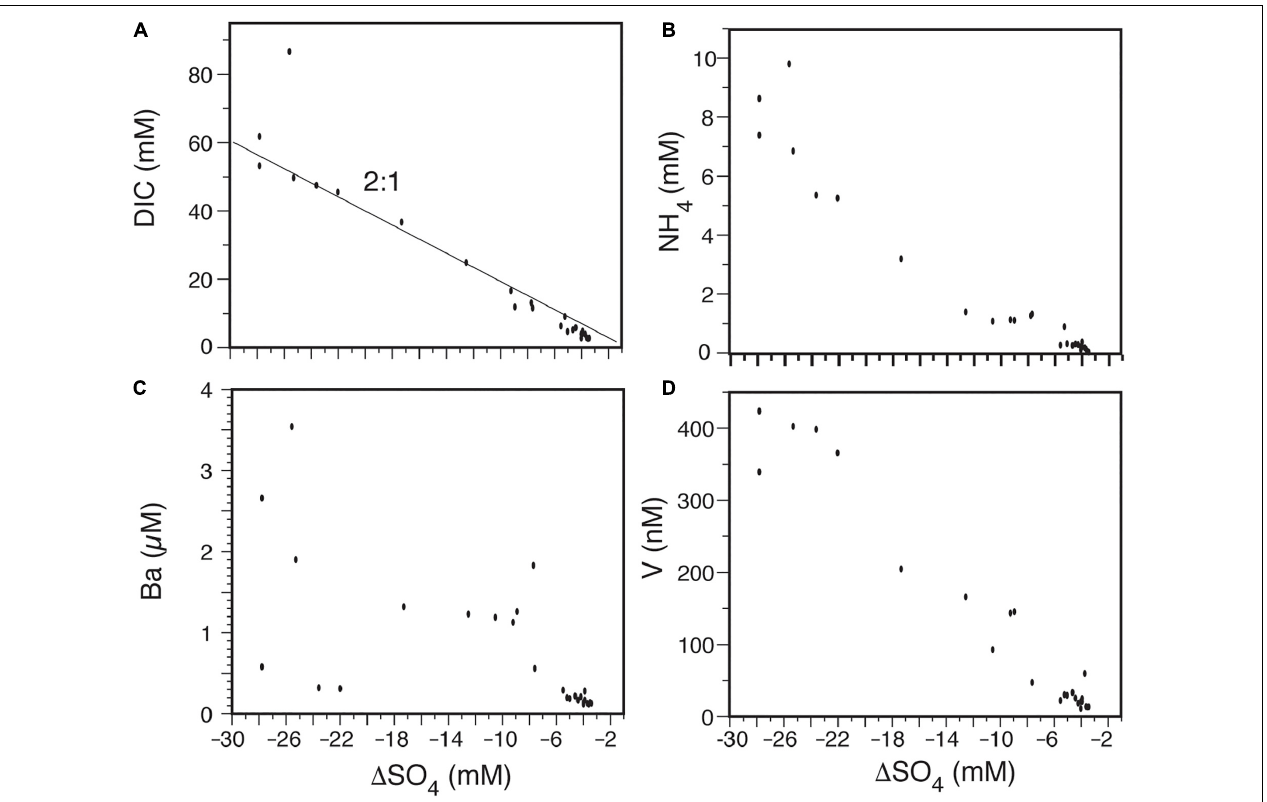
FIGURE 4 | Data from the Wadden Sea tidal flats, Germany, showing the relationship between sulfate depletion by C oxidation (see text) and dissolved species. (A) The concentration of dissolved CO 2 increases with a 2:1 ratio as sulfate is depleted (Eq. 2). (B) The concentration of dissolved NH 4 + reaches 8.5 mM in samples with the greatest sulfate depletion as predicted using the Redfield Ratio. (C) Dissolved Ba increases irregularly with increased sulfate depletion, implying organic matter degradation releases significant Ba either directly or due to secondary reactions. (D) Dissolved vanadium shows a highly linear increase with sulfate depletion, implying organic matter degradation releases significant V. Data from Riedel et al.